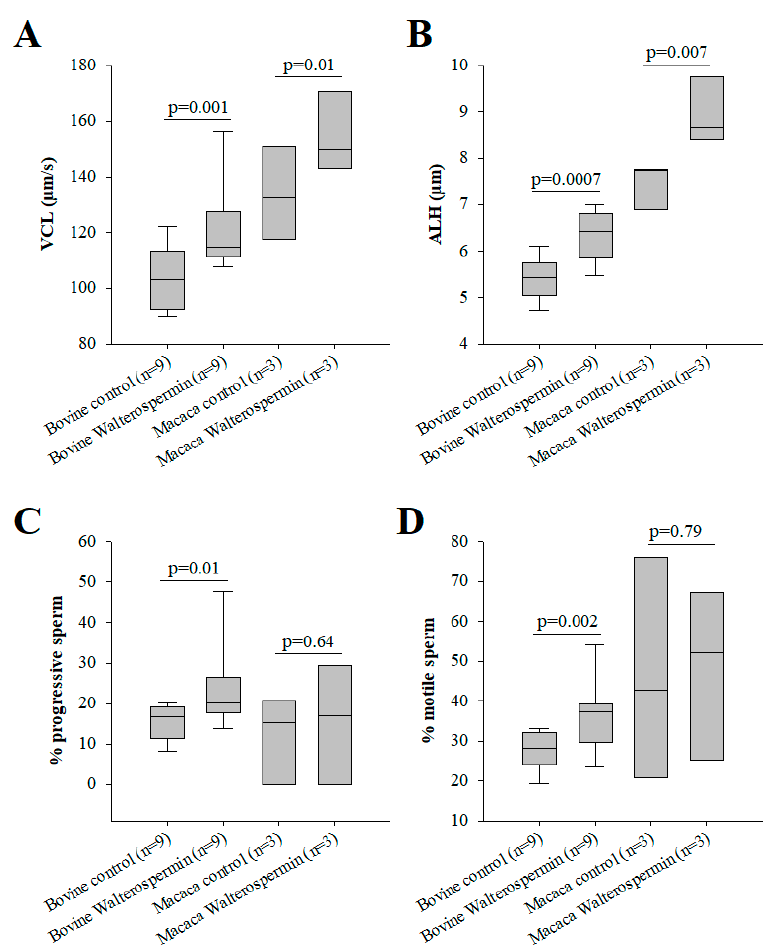
Figure 10. Bioactivity of synthetic walterospermin. ( A ) Increase in bovine and macaca sperm motility parameter VCL induced by 0.2 µM walterospermin. ( B ) Increase in bovine and macaca sperm motility parameter ALH induced by 0.2 µM walterospermin. ( C ) Effect of synthetic walterospermin on the percentage of motile sperm (non-progressive and progressive sperm combined). ( D ) Effect of synthetic walterospermin on the percentage of progressive sperm.